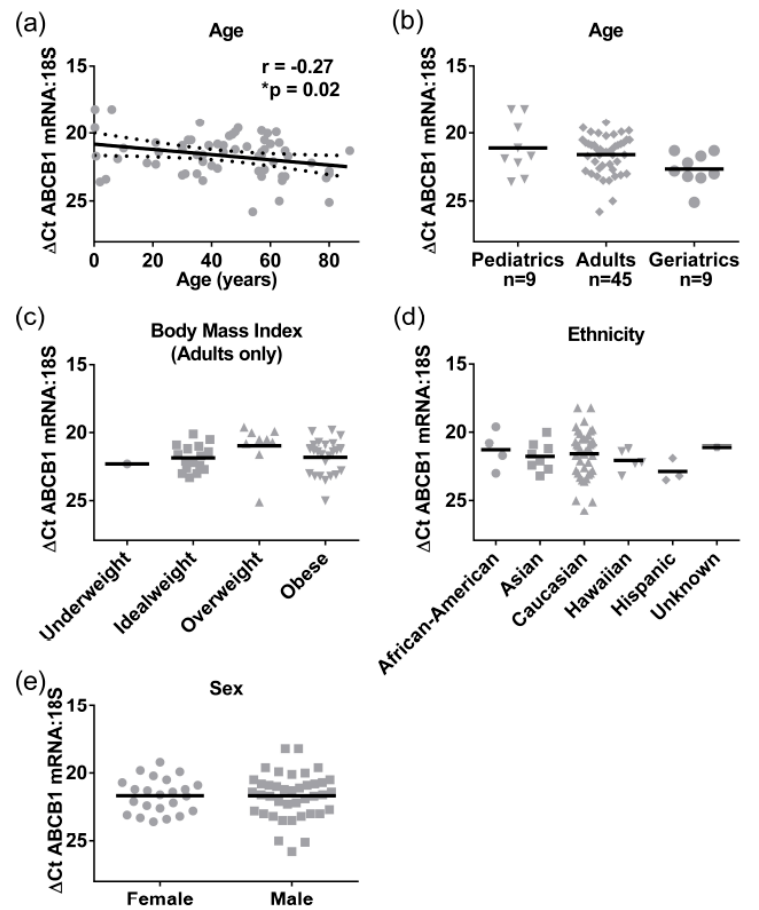
Figure 4. The mRNA expression of ABCB1 in a cohort of 80 liver samples. Gene expression was measured using SYBRGreen detection and ABCB1 gene expression was normalized to 18S to give ∆ C T value. ( a ) Line graph shows linear regression with 95% confidence intervals, (dotted line), of age compared to gene expression. Data analyzed by Pearson’s correlation (* p < 0.05); ( b ) Dot blot compare gene expression levels with age grouped into pediatric ( ≤ 18 years), adult (19–64 years), and geriatric ( ≥ 65 years) and data showing mean (horizontal line). The mRNA expression was also compared to ( c ) obesity, measured by BMI, ( d ) Ethnicity, and ( e ) Sex.